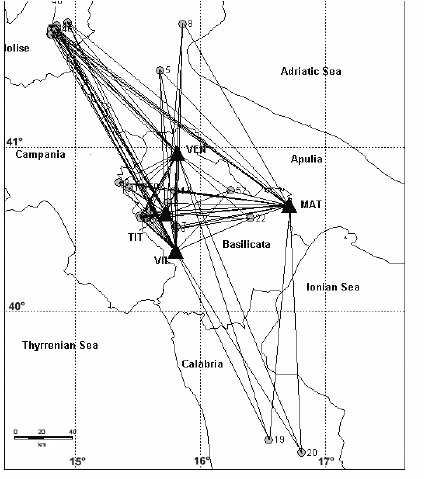
Fig. 2. Hypocentral distance versus magnitude dis- tribution of velocity records